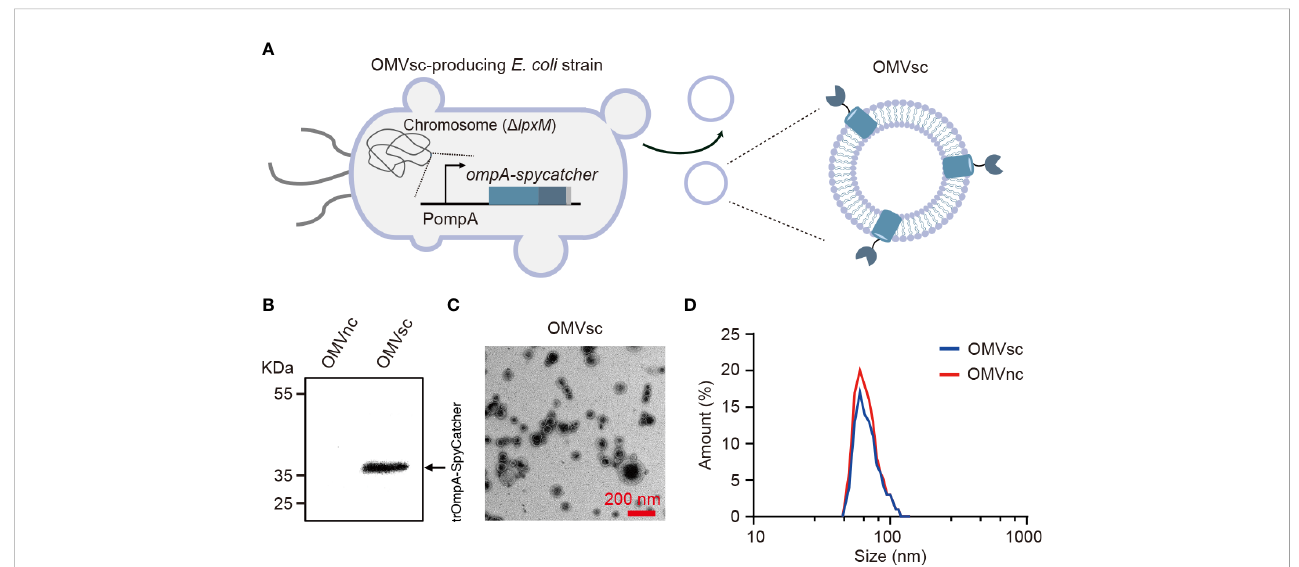
FIGURE 1 Generation and characterization of engineered bacterial OMVs. (A) A schematic diagram of the D lpxM ompA-spycatcher E coli strain producing engineered OMVs containing trOmpA (a.a 1-155)-SpyCatcher fusions. (B) Western blot analysis of OMVs puri fi ed from D lpxM ompA-spycatcher (OMVsc) and the D lpxM strain (OMVnc). An anti-His 6 primary antibody was used to detect the trOmpA-SpyCatcher-His 6 fusion protein. (C) A randomly selected transmission electron microscopy (TEM) image of OMVsc. Scale bar: 200 nm. (D) Nano- fl ow cytometry analysis of the size distribution of OMVsc and